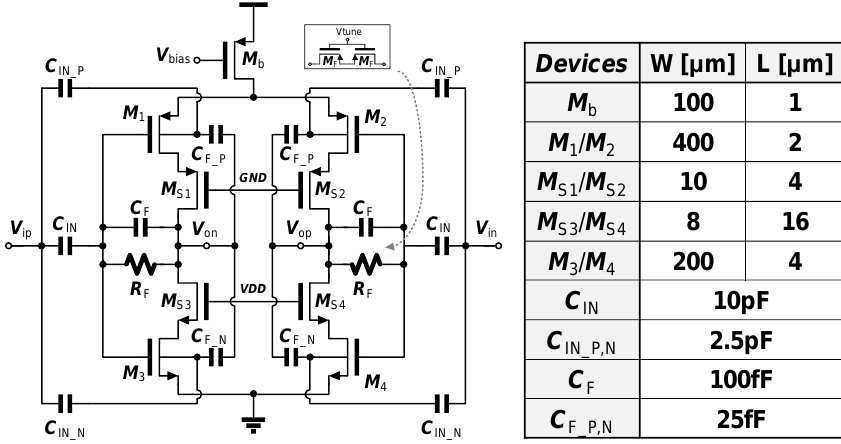
Figure 4. Schematic of the double-gated, push-pull preamplifier and the table of dimensions and values for the transistors and capacitors used in the preamplifier.